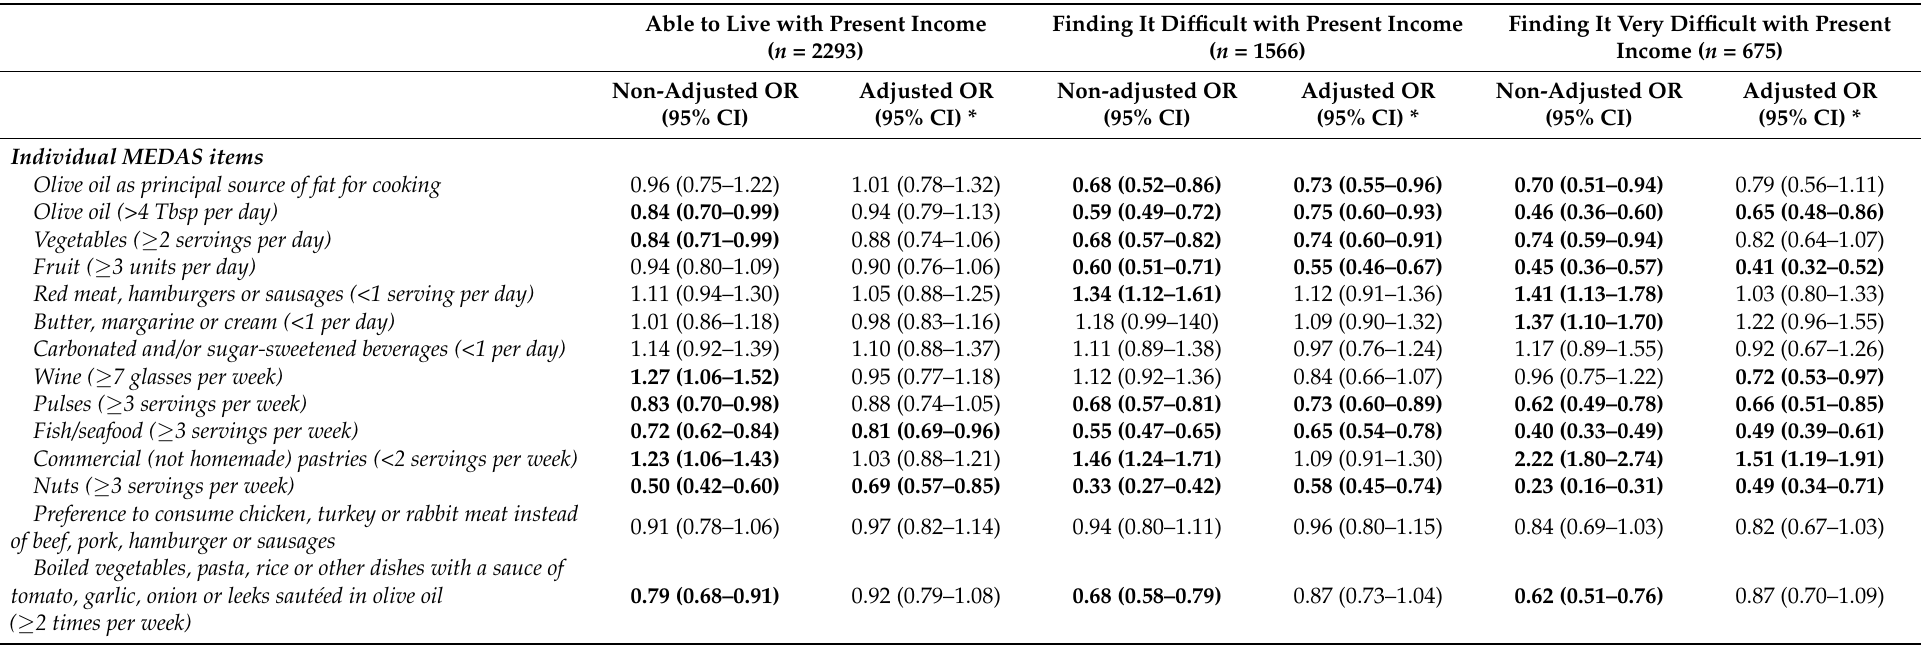
Table 3. Odds of individual MEDAS items according to income perception